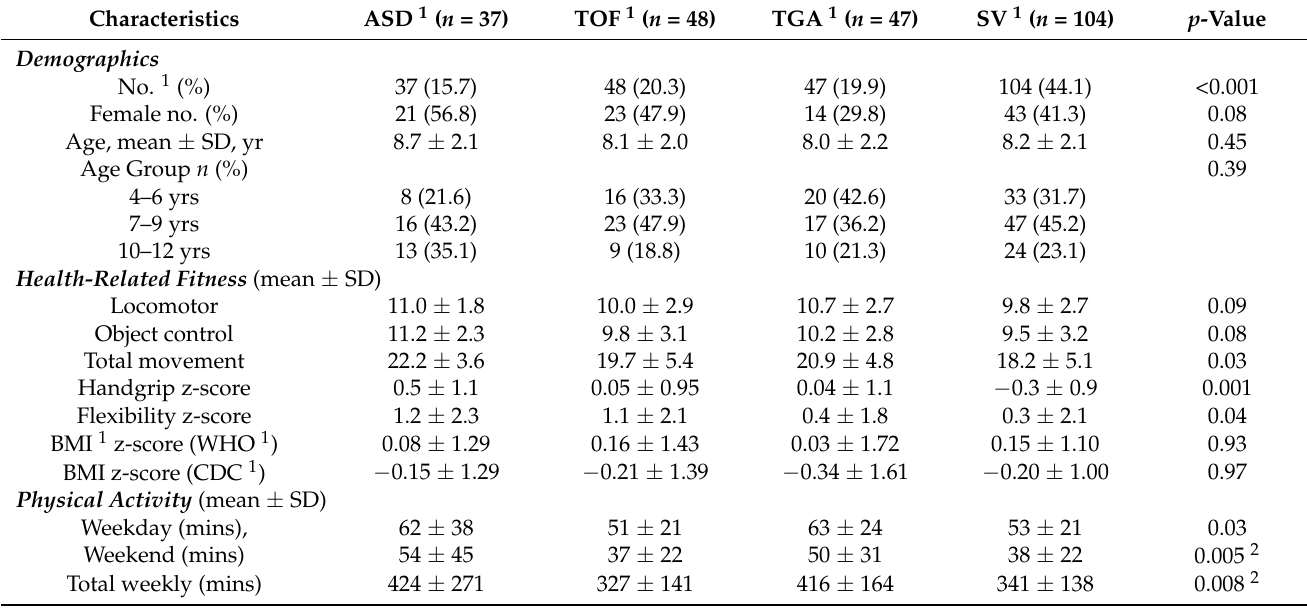
Table 1. Participant